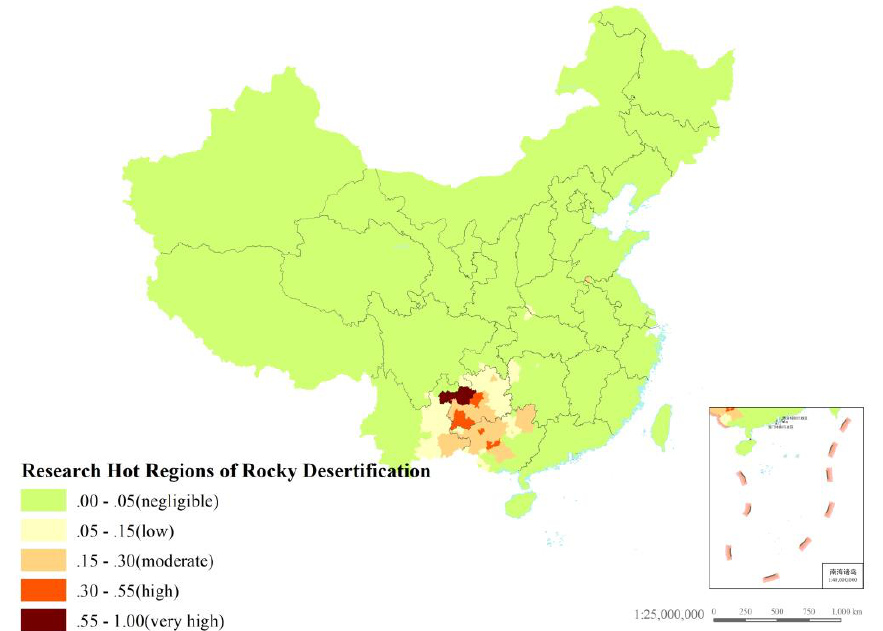
Figure 4. The Map of Hot Regions of Rocky Desertification Research in China.